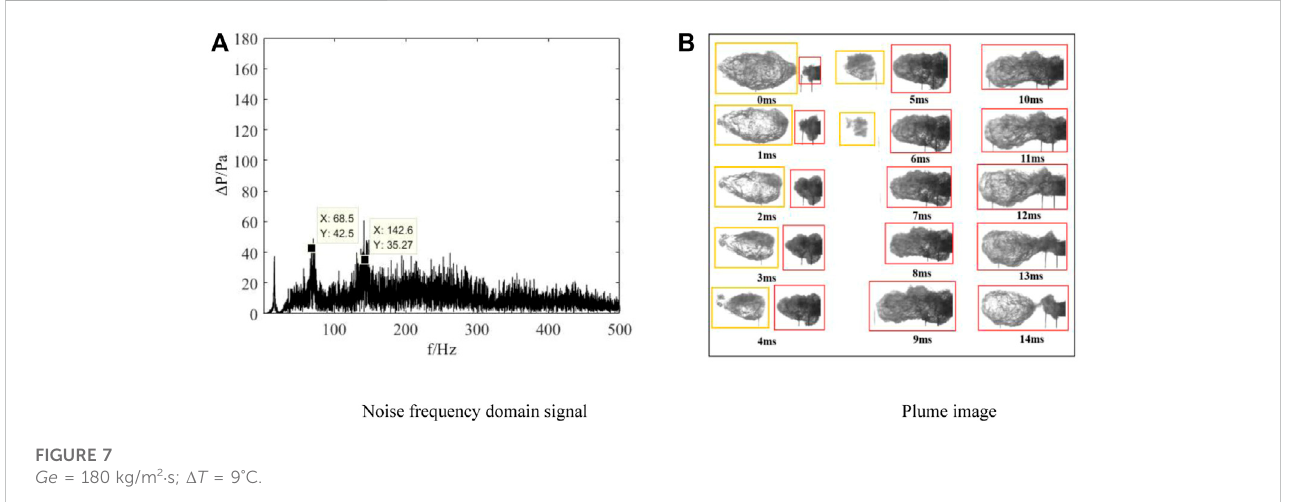
FIGURE 7 Ge = 180 kg/m 2 · s; Δ T = 9 ° C.